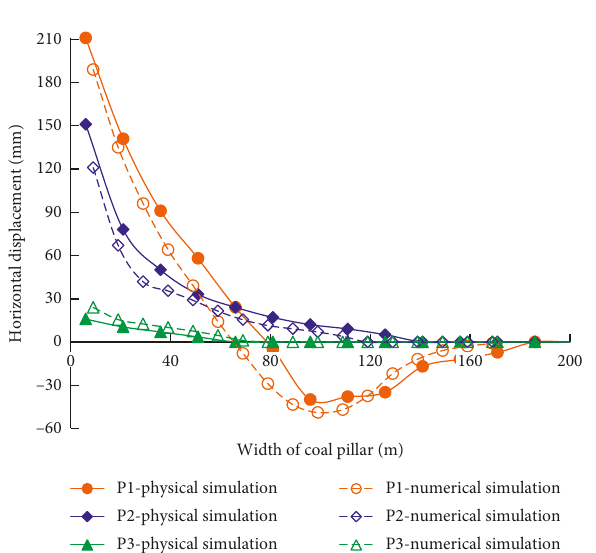
Figure 8: Variations in the horizontal displacements of the monitoring points with the coal pillar width.